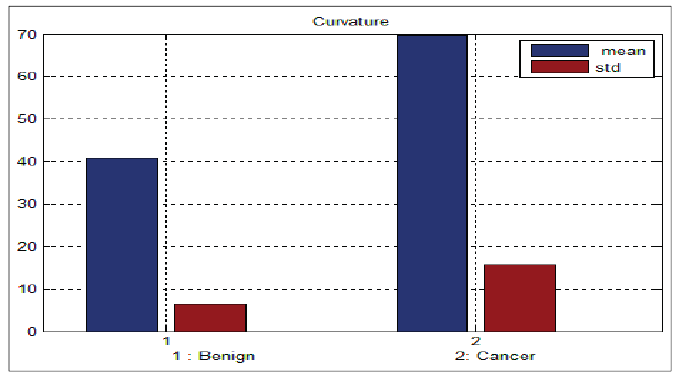
Figure 10. Mean and standard deviation for the